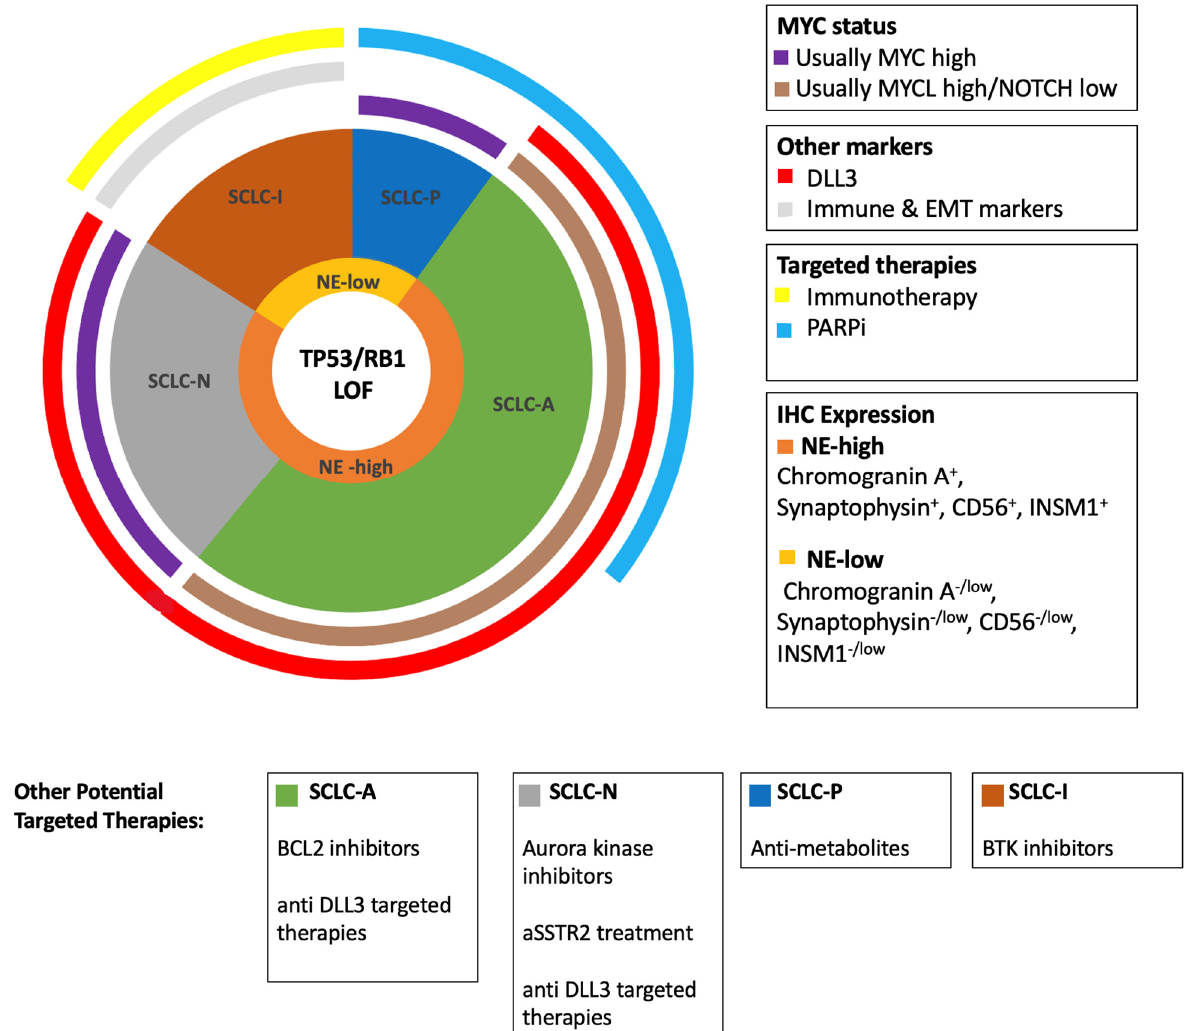
Figure 4. Chart of the relative abundance, MYC and Notch status, NE status, and promising targeted therapies in the four molecular subtypes of SCLC, each identified by their key transcriptional regulator. Loss of function (LOF) of RB1 and TP53 is obligatory in SCLC.